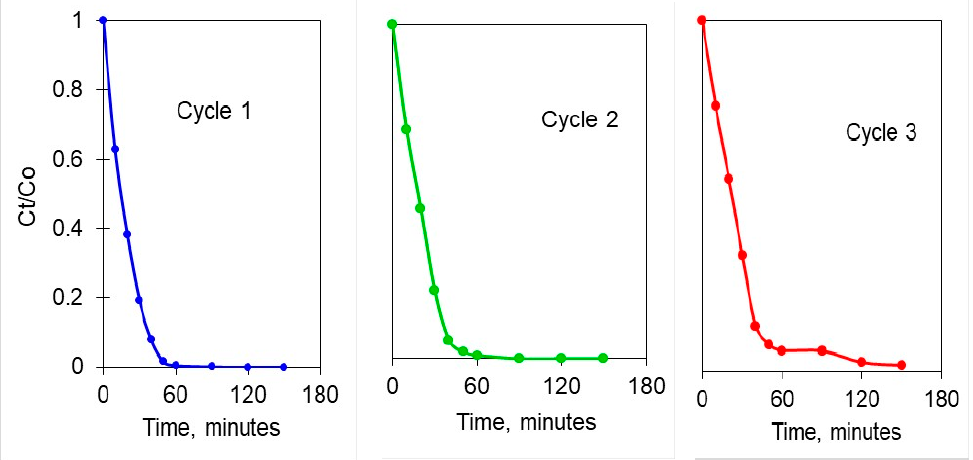
Figure 14. Clofibric acid elimination with Zn4La400 during three consecutive cycles (catalyst load 500 mg / L, initial pollutant concentration 3 mg / L, natural solution pH, stirring rate of 450 rpm, 500 mg/L, initial pollutant concentration 3 mg/L, natural solution pH, stirring rate of 450 rpm, UV-A UV-A irradiation).